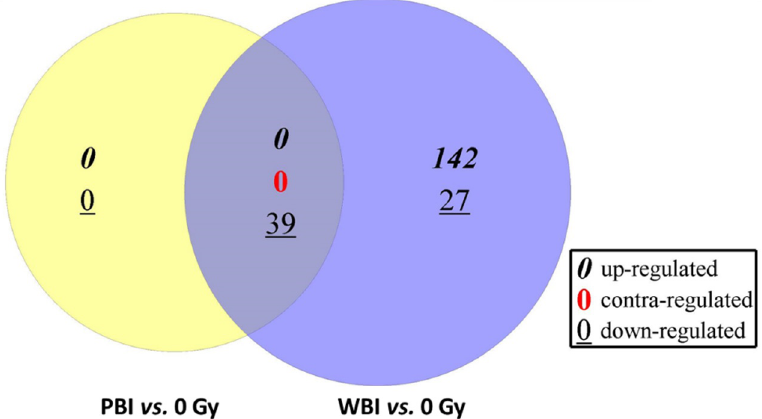
Figure 3. Venn diagram showing overlap between the statistically significant miRNAs perturbed in in PBI ( left side) and WBI mouse hearts ( right side). All miRNAs in common were down-regulated. Table 2. List of statistically significant miRNAs in common between PBI and WBI mouse hearts. These 39 miRNAs are the ones of the Venn diagram in Figure 3 obtained by intersecting deregulated miRNAs in PBI and WBI.